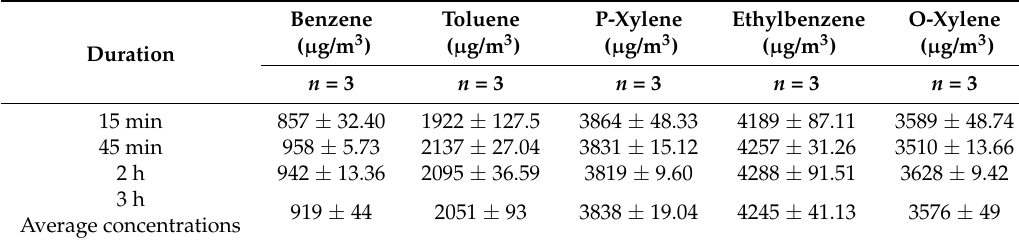
Table 3. Time-weighted average BTEX room